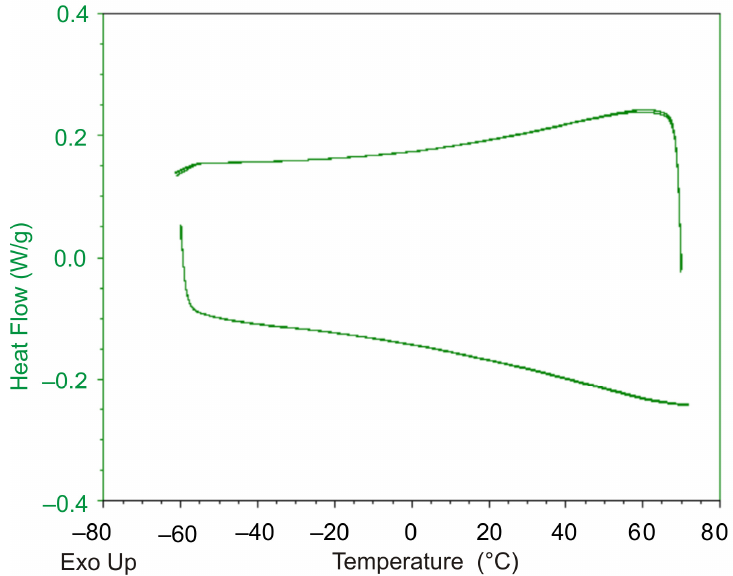
Figure 14. Dependence of heat flow on temperature recorded for DeSolite DS-2015 polymer (differ- ential scanning calorimeter data). ential scanning calorimeter